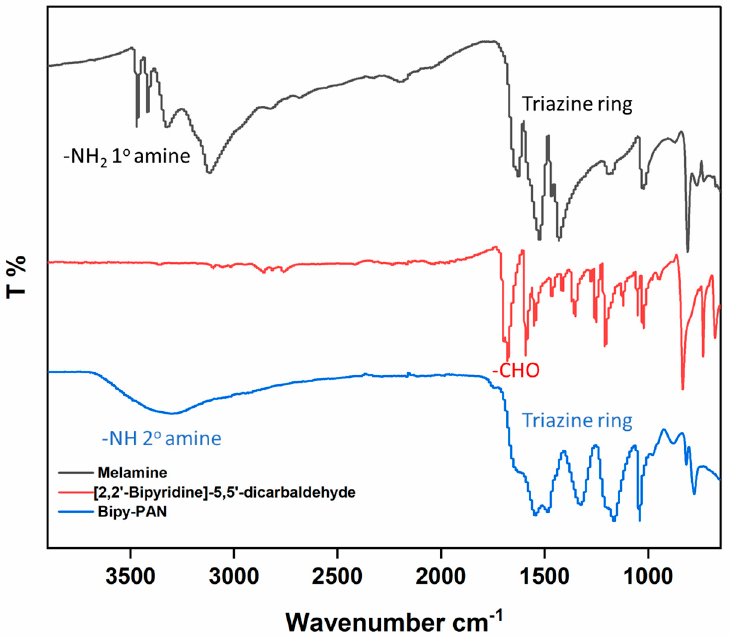
Figure 1. FT-IR spectra of melamine, pyridine dialdehyde and BiPy-PAN.